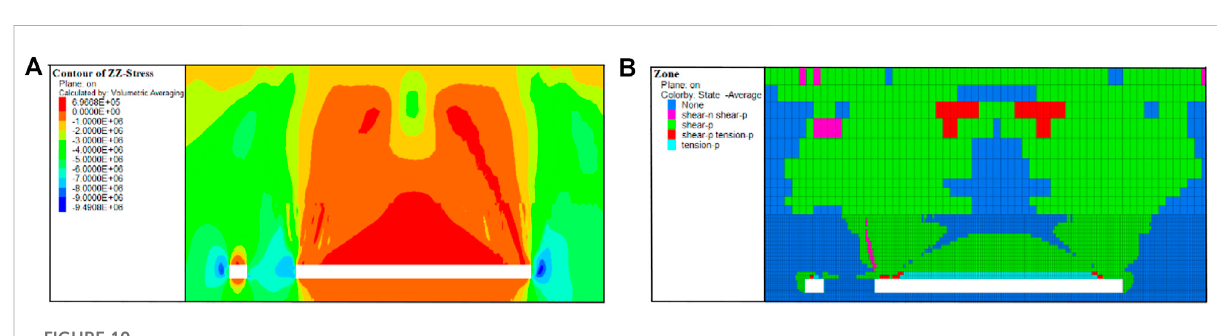
FIGURE 10 Distribution of vertical stress and plastic zones after mining block 1. (A) Vertical stress distribution after mining block 1; (B) plastic zone distribution after mining block